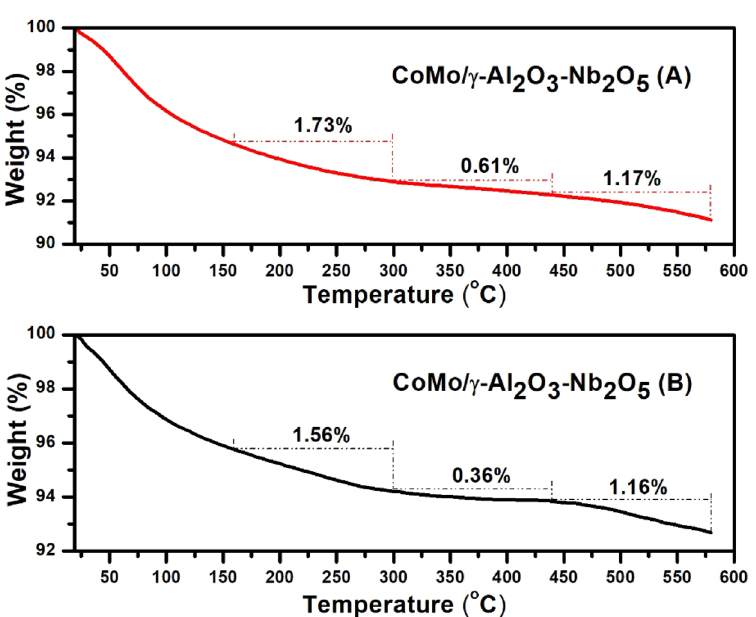
Figure 4. Temperature-programmed desorption curves of diethylamine for CoMo/γ-Al 2 O 3 –Nb 2 O 5 catalyst before ( A ) and after ( B ) sulphidation.